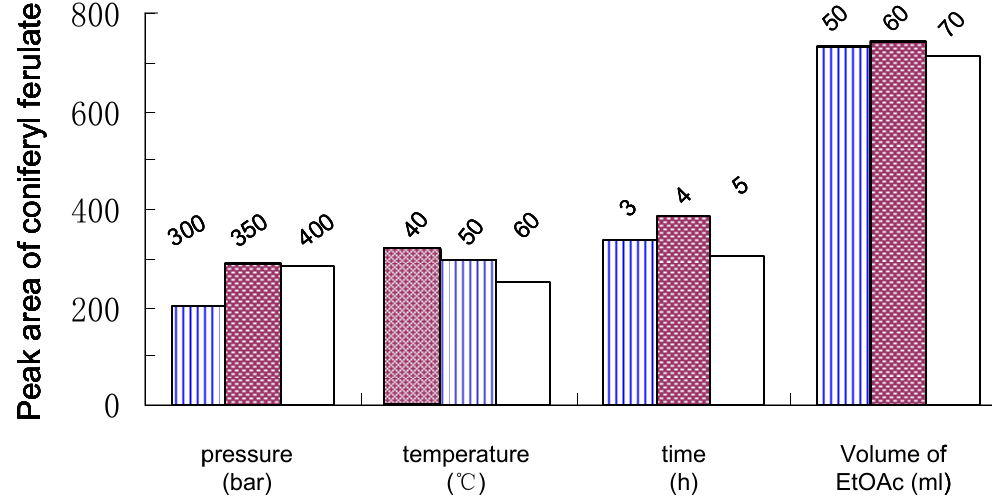
Figure 2. Effects of pressure, temperature, extraction time, volume of ethyl acetate on SFE of coniferyl ferulate from Angelica sinensis